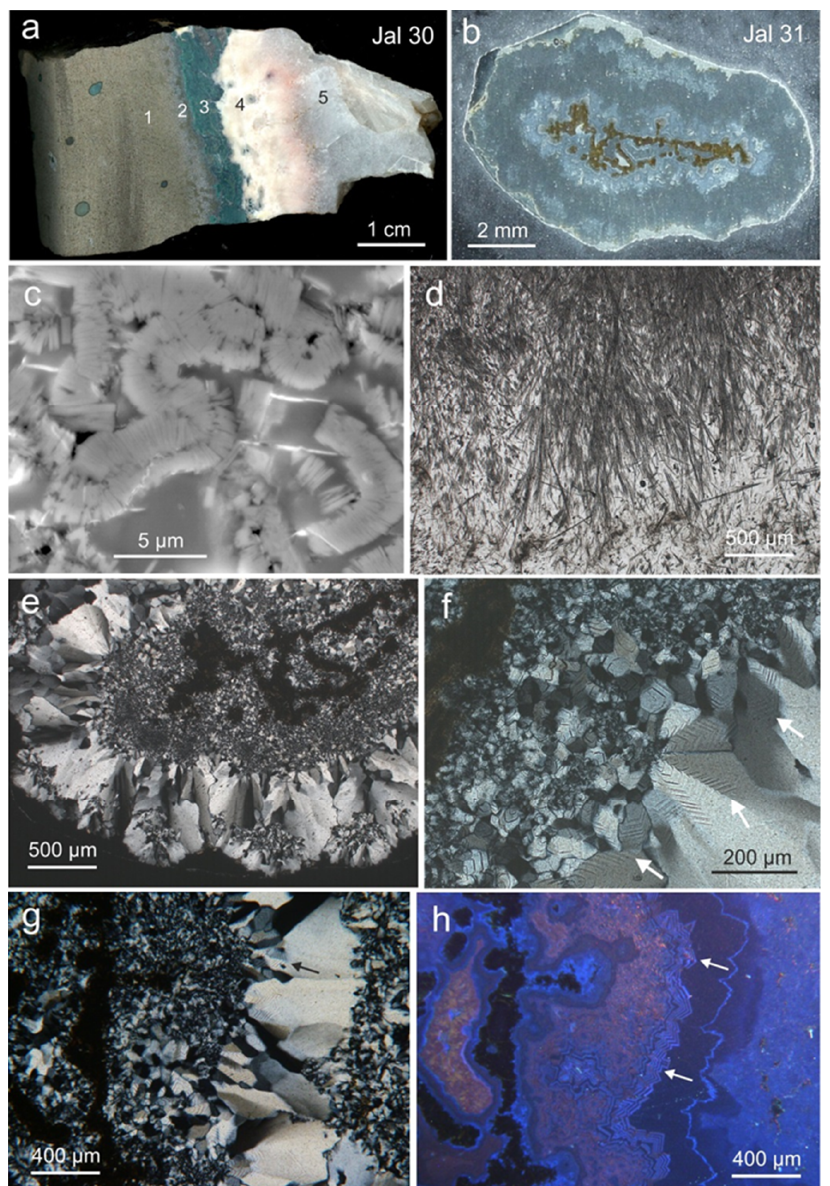
Figure 7. Images and micrographs showing the characteristic composition and texture of samples Jal 30 and Jal 31 (Jalgaon/Savda): ( a ) hand specimen showing the typical transition zone between basaltic host rock and mineralization from a cavity of the outcrops in Jalgaon/Savda (sample Jal 30), with numbers relating to different zones (for explanation see text); ( b ) cross-section of a filament from a cavity in Jalgaon/Savda (sample Jal 31) showing an irregular brown core filament; ( c ) SEM micrograph of zone 3 showing agglutinated platelets of celadonite forming worm-like textures; ( d ) transmitted light micrograph of acicular mordenite bundles within a homogeneous SiO 2 matrix; ( e ) transmitted light (crossed polars) micrograph showing the filament center encrusted with micro- and macro-crystalline quartz; ( f ) details of the filament cross-section illustrating the SiO 2 mineralization directly on the core filament surface and the succeeding grain-coarsening during crystallization, note the µ m-sized growth lamellae (arrows), so-called Bambauer quartz; ( g , h ) polarized light / cathodoluminescence (CL) micrograph pair revealing the zoned crystallization sequence of silica phases, the zones with growth lamellae being clearly visible in CL (see arrows).